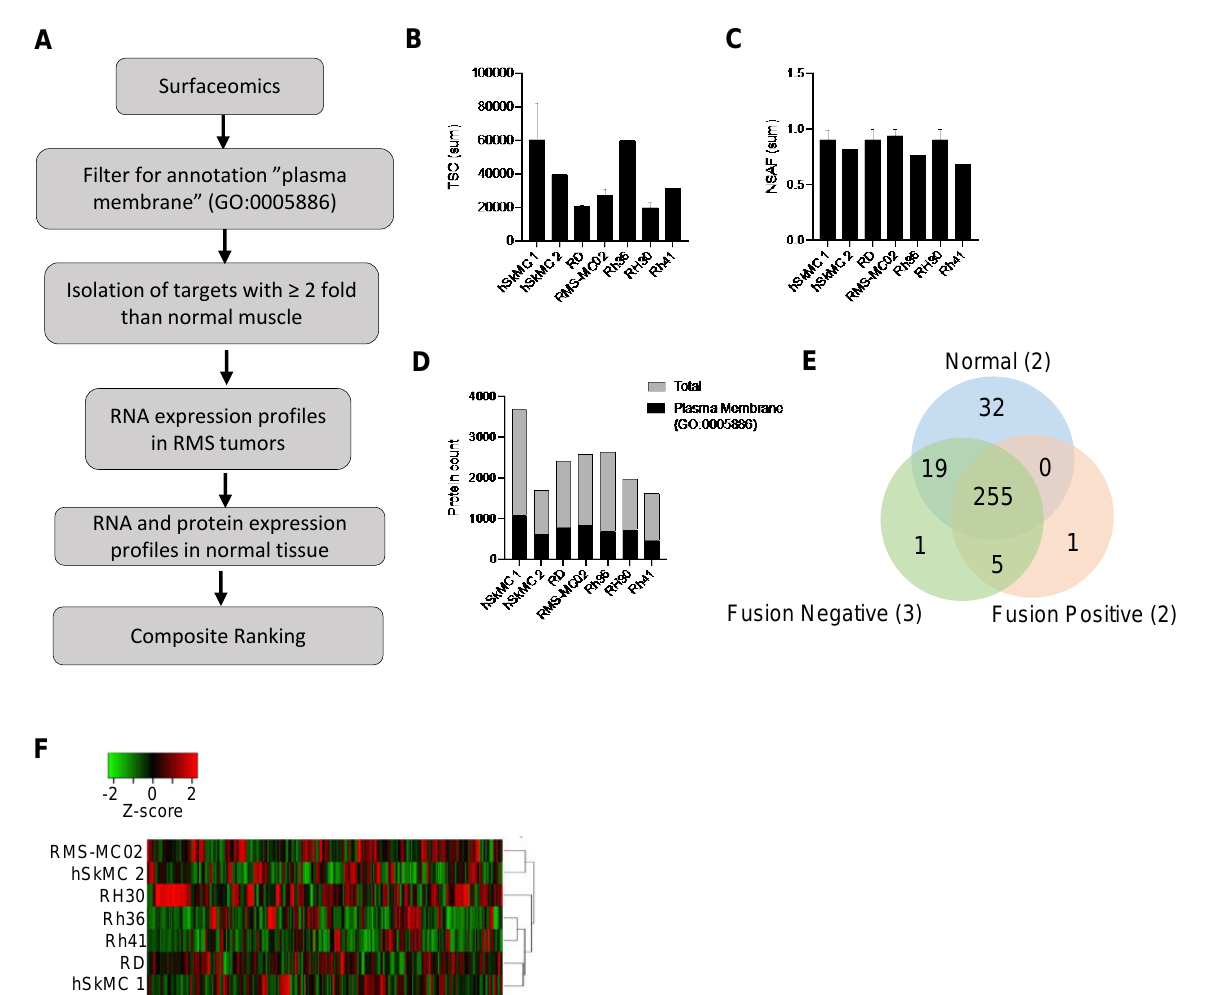
Figure 1. Distinct cell-surface protein signatures are identified in RMS subtypes and normal muscle. ( A ) Overall representa- tion of the bioinformatics strategy to identify highly confident RMS-enriched cell surface proteins by combined proteomic and transcriptomic analysis of RMS. ( B ) Sum of TSC (total spectral count) and ( C ) NSAF (normalized spectral abundance factor) for each cell line analyzed. ( D ) Total protein count for each cell line. Count of proteins with the annotation plasma membrane is superimposed on the total protein count (black bars). ( E ) Venn diagram showing number of proteins identified in all cell lines of each subtype. ( F ) Heatmap of hierarchical clustering for cell surface protein data set filtered with the annotation “plasma membrane” (GO:0005886), Average linkage, Euclidean